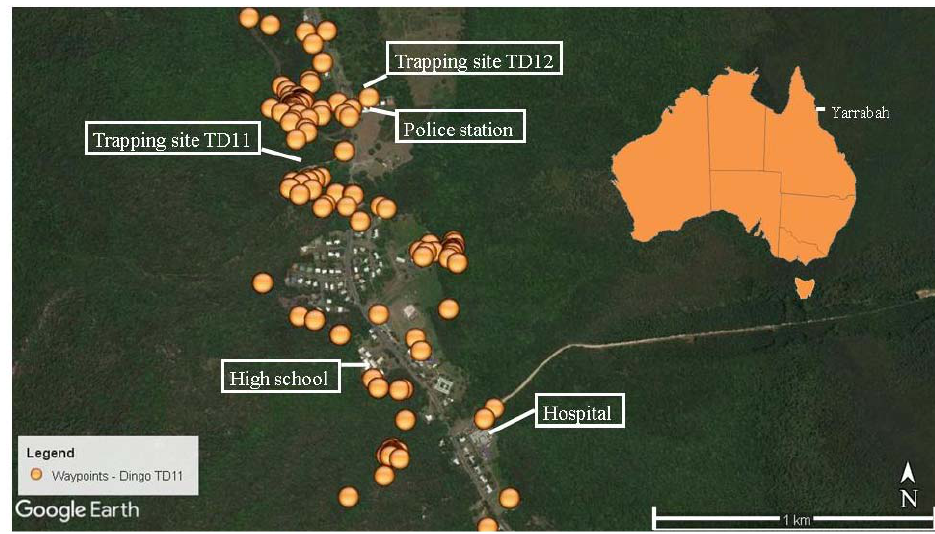
Figure 1. Waypoints collected in Yarrabah over a seven-day period (7 November 2013 to 14 November 2013) for female dingo TD11.